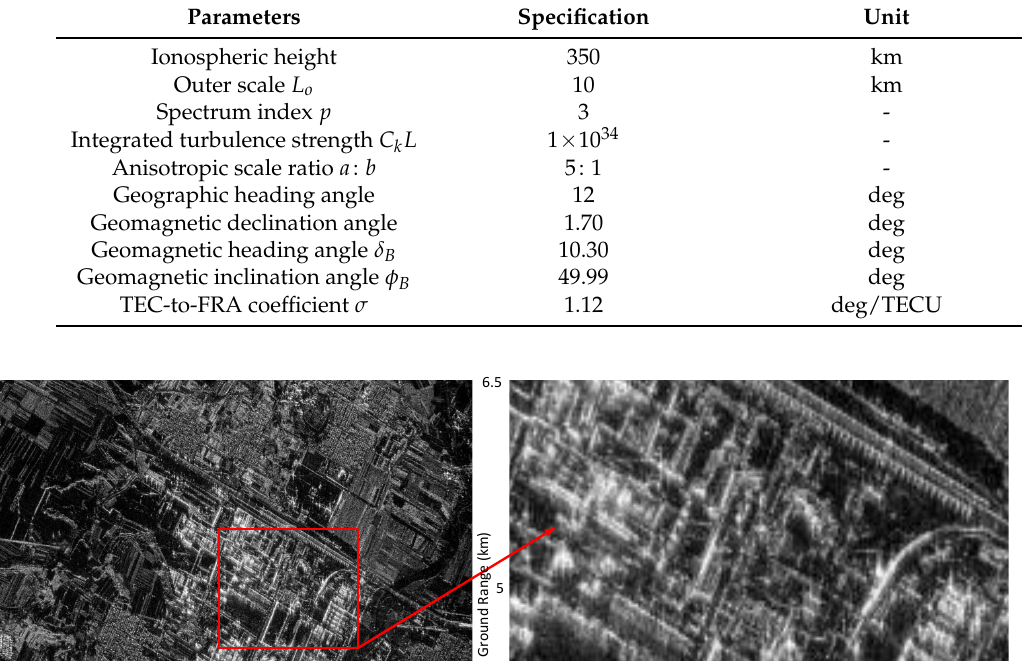
Table 2. Ionospheric Parameters.